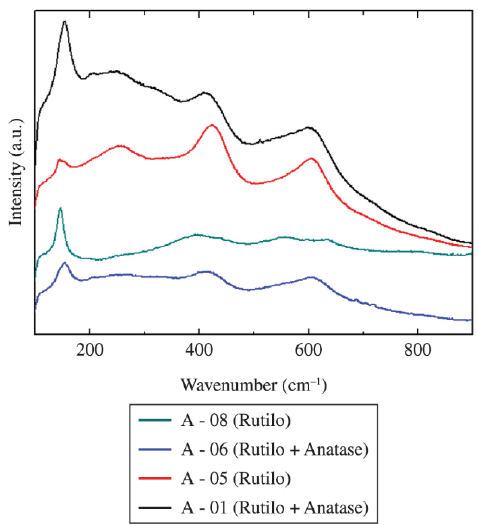
Figure 8. Raman spectra of the double titanium cage deposited samples at different conditions. The samples A-01 and A-05 were deposited at 350ºC, with a gaseous mixture of 06 sccm H + 06 sccm 2 Ar + 03 sccm O and the treatment time lasted 4 and 6 hours, 2 respectively. The samples A-06 and A-08 were deposited at 350ºC,with